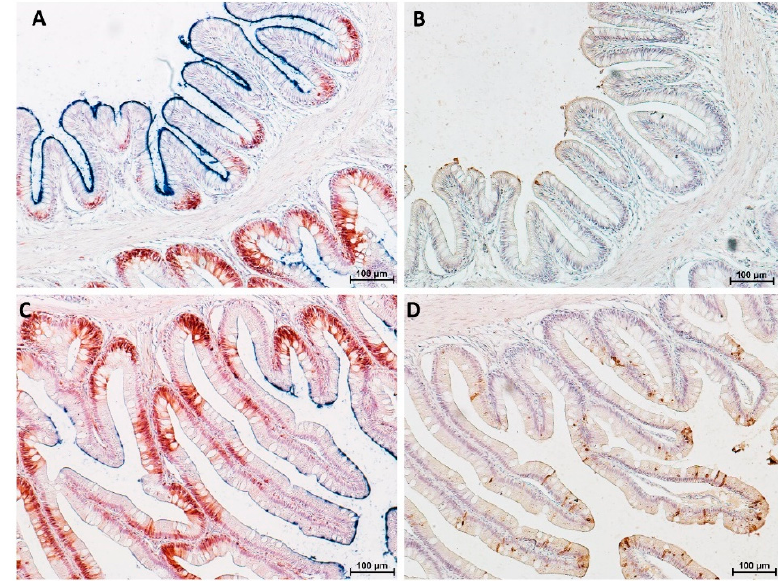
Figure 19. Representative figure of PCNA immunolocalization (red), histochemical detection of differentiated cells (blue) and in situ detection of apoptotic cells (brown). The apical part of the complex folds was characterized by a low PCNA expression, few round apoptotic cells and a strong alkaline phosphatase signal ( A , B ). In contrast, high proliferation and high apoptotic rate associated with low alkaline phosphatase expression in the basal part of the complex folds were observed ( C , D ).